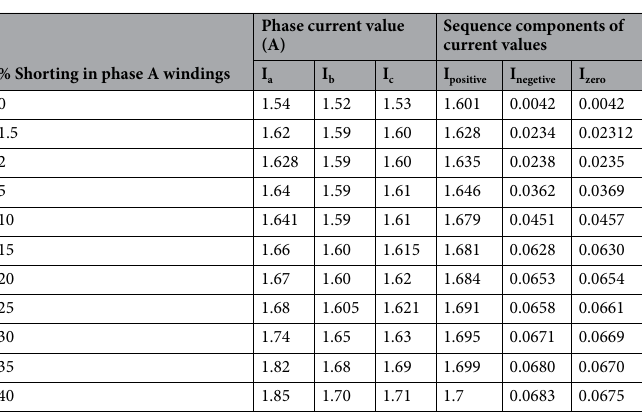
% Shorting in phase A